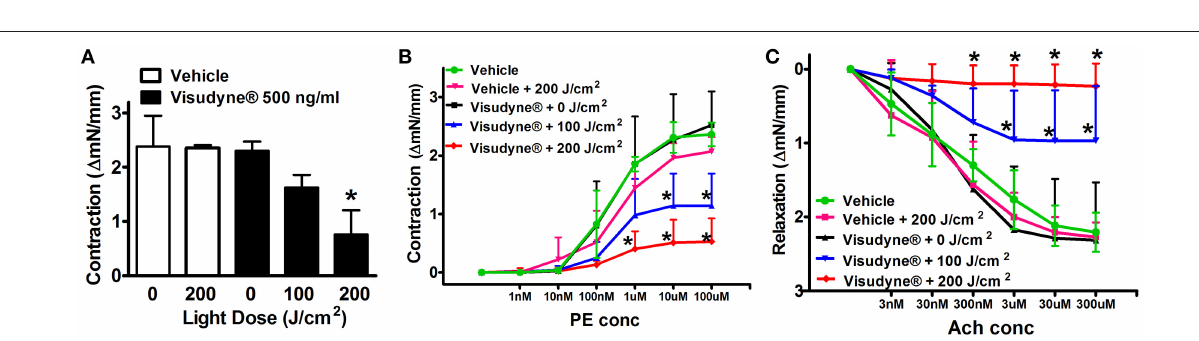
FIGURE 7 | Visudyne ® -PDT mediated macrophage apoptosis. (A) Representative images showing TUNEL-positive signal (green), F4/80-positive (red), Hoechst (blue), and merged image in Visudyne ® treated arteries photoirradiated with 0J/cm 2 (upper panel, n = 3), 100J/cm 2 (middle panel, n = 3), or 200J/cm 2 (lower panel, n = 4). Scale bar: 25 µ m. (B) Percentage of apoptotic macrophages was assessed as the percent of TUNEL + F4/80 + cells to the total number of cells. * P < 0.001 vs. 0J/cm 2 .